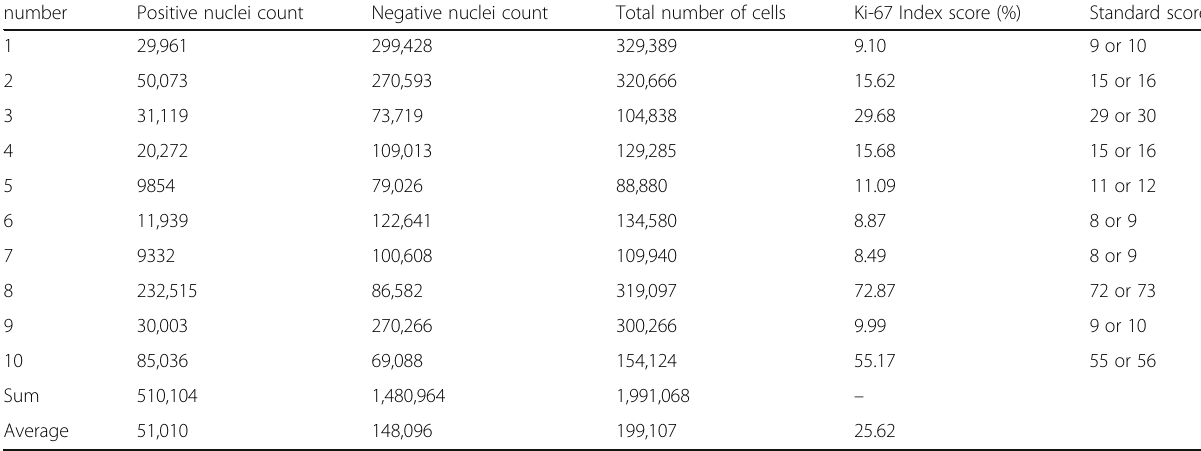
Table 3 Manual labelling of “ gold standard ” results for Ki-67 positive cells in the human-machine challenge